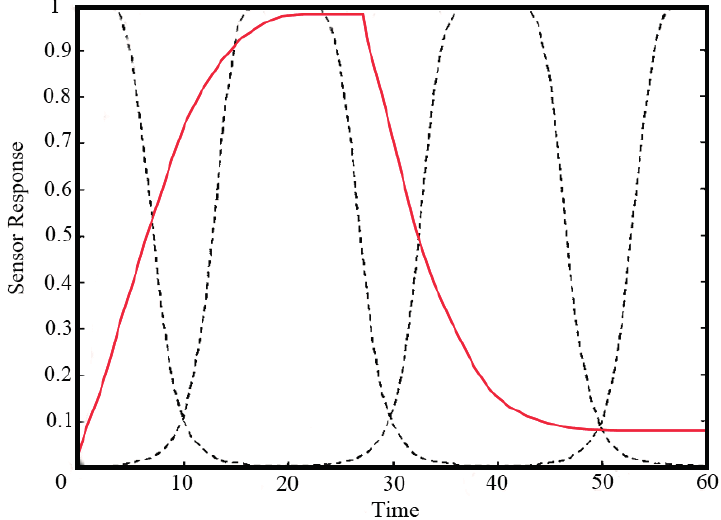
Figure 3. Temporal representation of